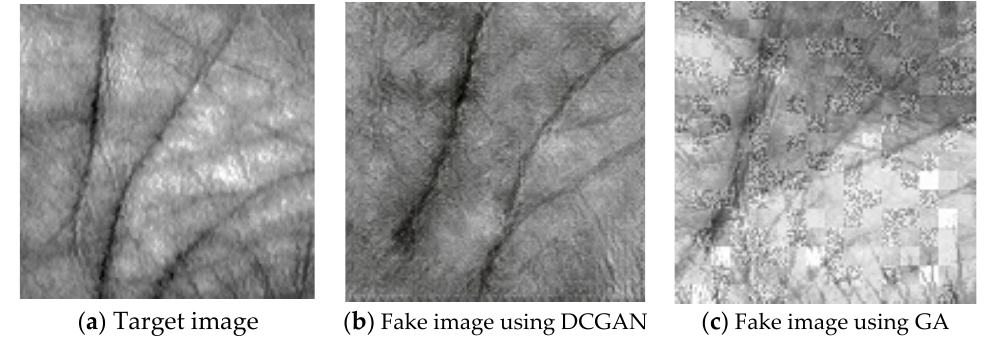
Figure 8. Image samples in three image sets.